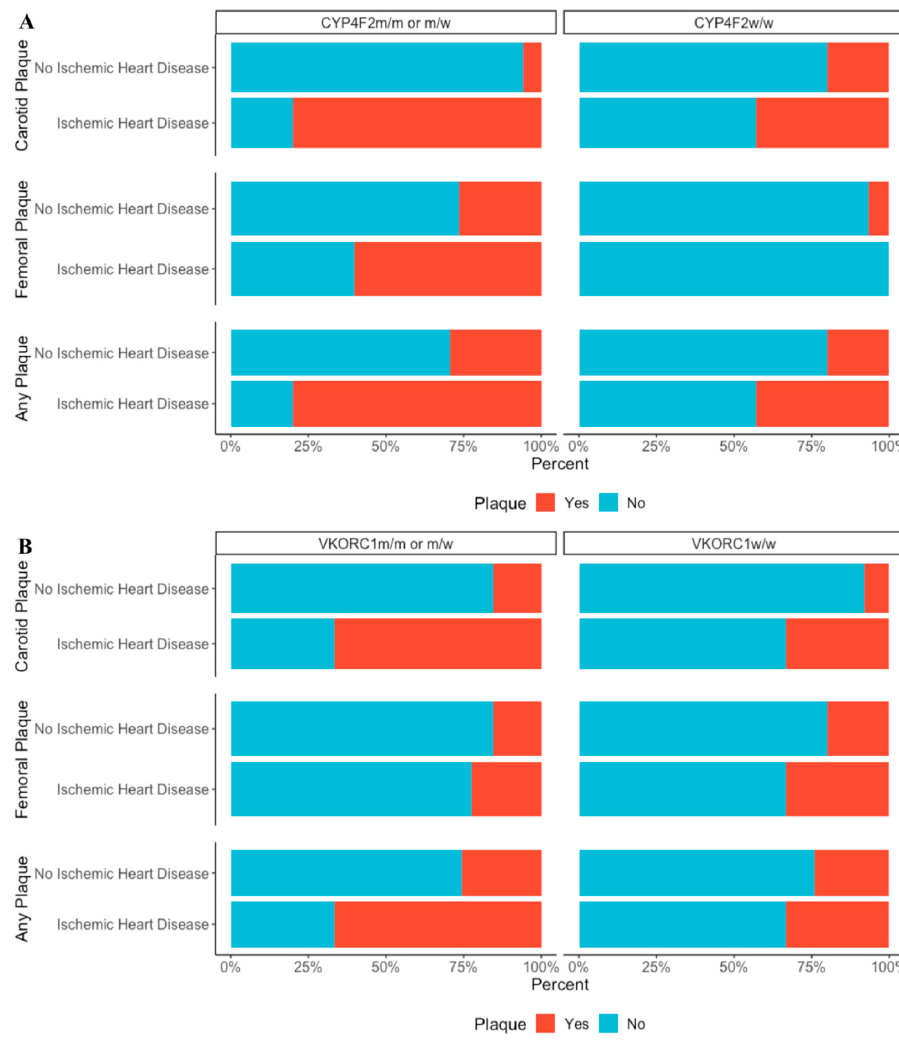
Figure 1. ( A ) CYP4F2 interaction with ischemic heart disease in predicting plaque formation. ( B ) VKORC1 interaction with ischemic heart disease in predicting plaque